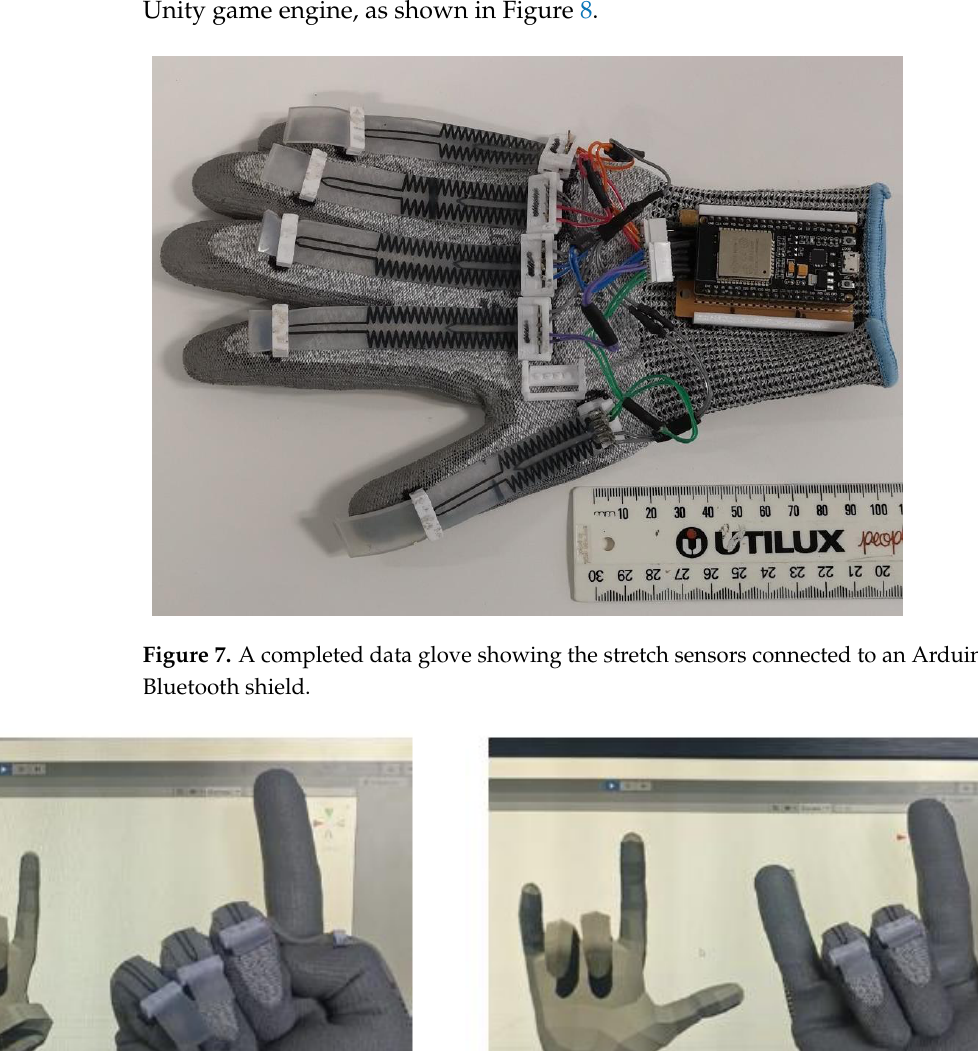
Figure 8. Examples of hand gestures and their presentation on the computer screen.